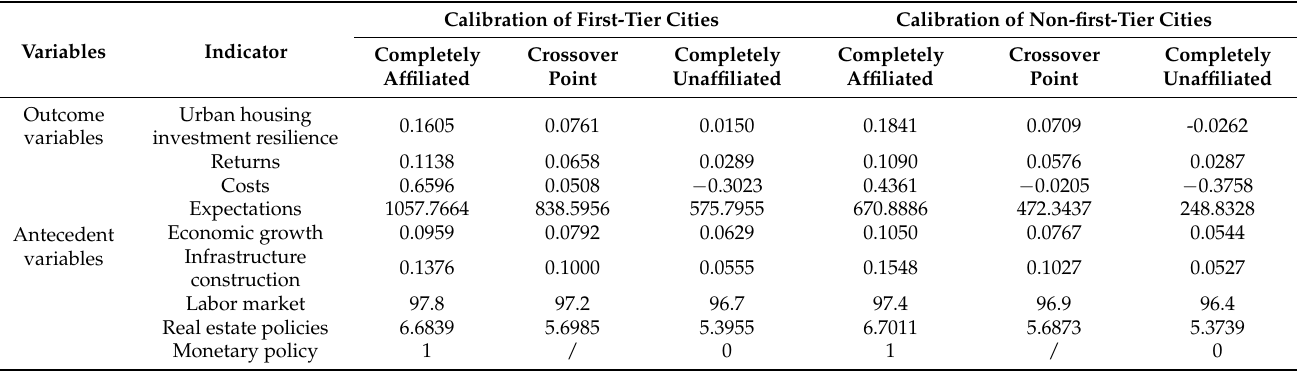
Table 1. Calibration of antecedent and outcome